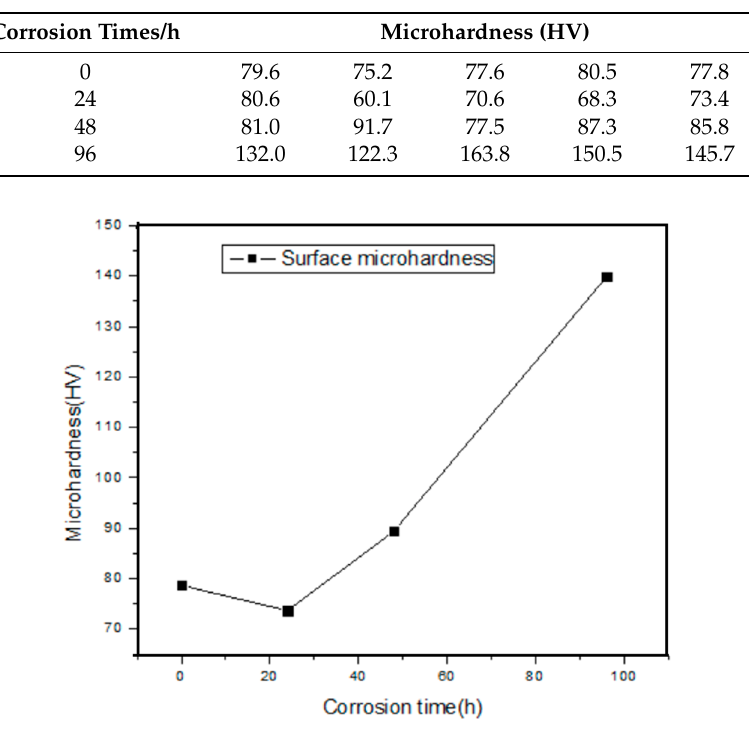
Figure 7. Microhardness of coatings on different corrosion time.